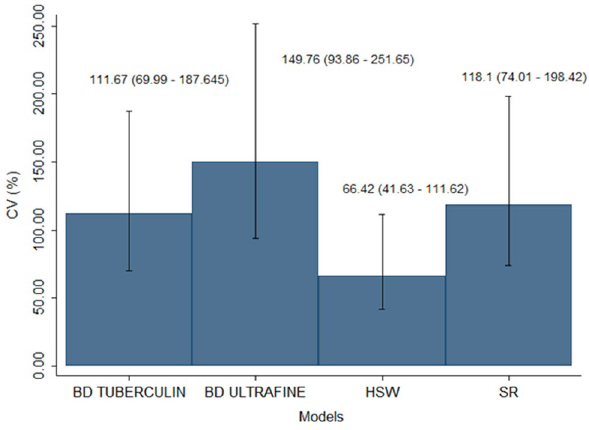
Figure 1. Coefficients of variation (CV) of the syringe models. The Feltz and Miller asymptomatic test was used for CV comparisons—Chi2(3) = 1.47 ( p =